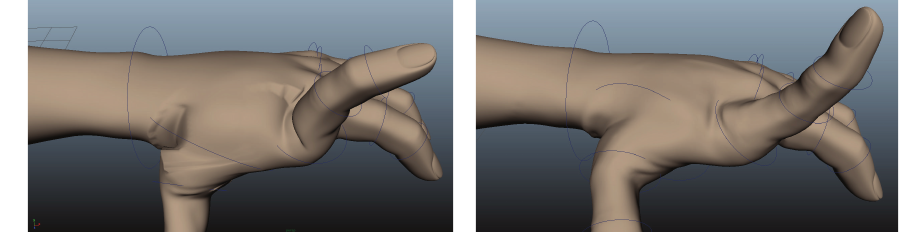
Figure 5: Before and after adjusting skin weights.